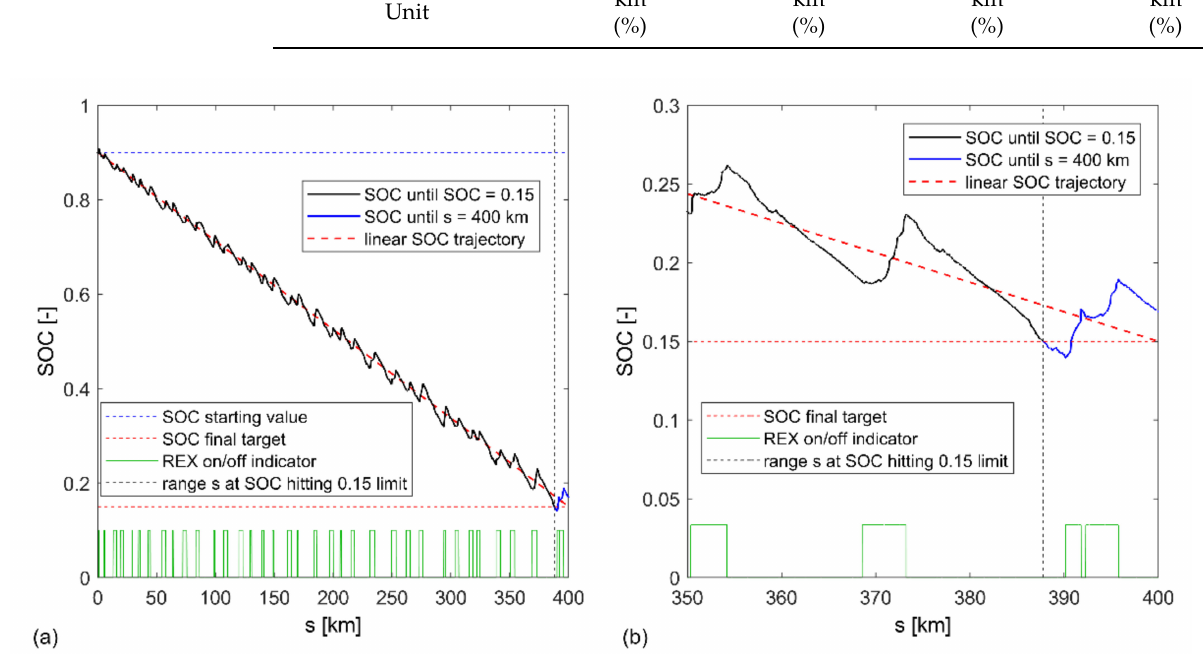
Figure 9. Plots of SOC versus traveled distance s in FTP-75 driving cycle ( a ) for the entire drive over 400 km distance, ( b ) zoom on final 50